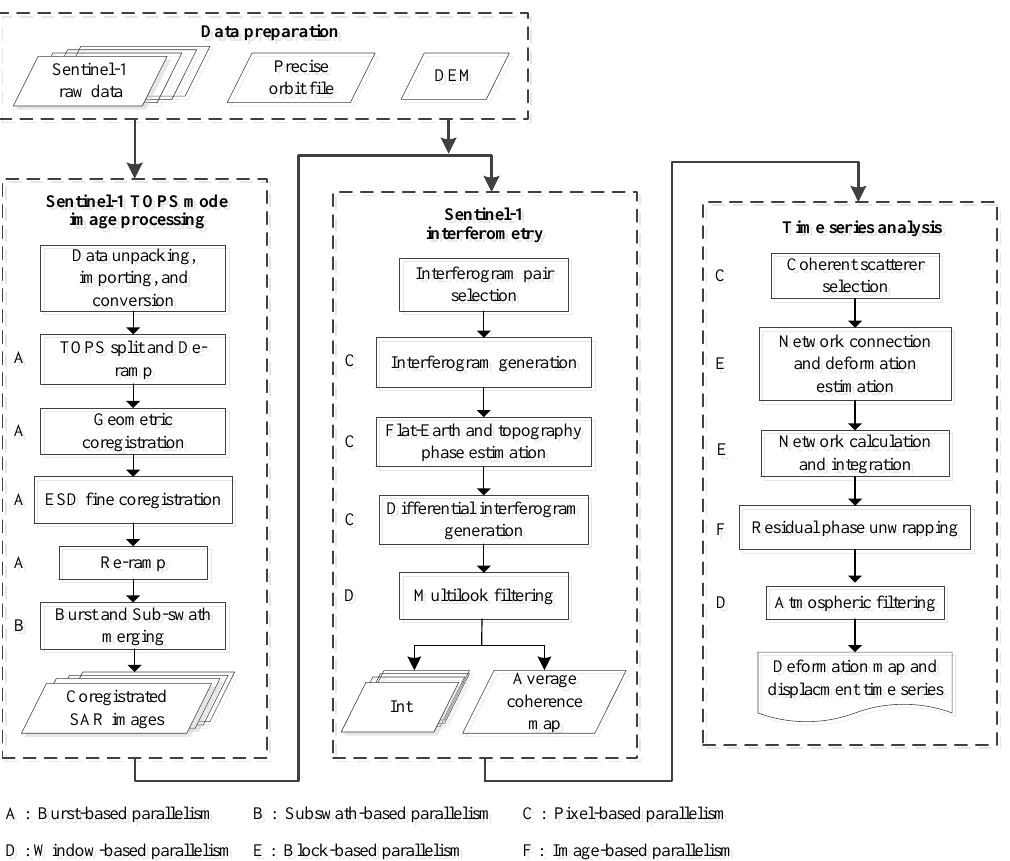
Figure1. Theworkflowoftheproposedparallelcomputing-basedcoherentscattererInSAR(P-CSInSAR) Figure 1. The workflow of the proposed parallel computing-based coherent scatterer InSAR (P- algorithm. The di ff erent letters represent the adopted parallelization strategies at di ff erent CSInSAR) algorithm. The different letters represent the adopted parallelization strategies at different levels.